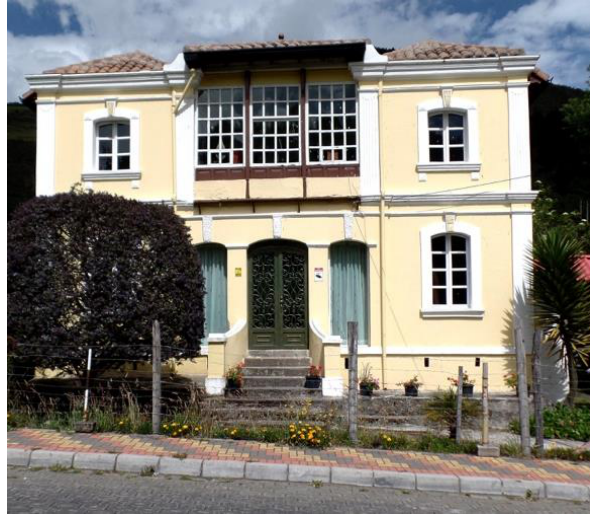
Figure 1. Hacienda type house, Nono, Ecuador, 2019.